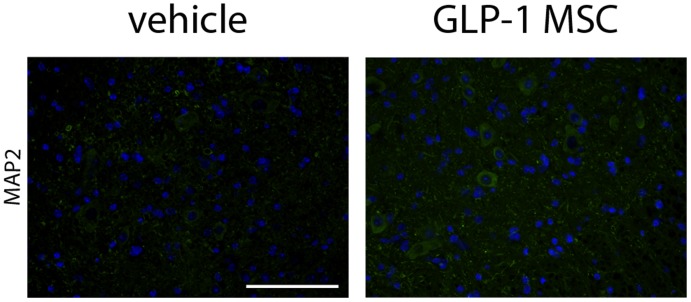
Immunhistological analysis of MAP2 in spinal cord tissue of SOD1 (G93A) mice.Staining against microtubule associated protein 2 was stronger in animals treated with GLP-1 (GLP-1 MSC) compared to vehicle treated controls (vehicle). Scale bar 100 µm.